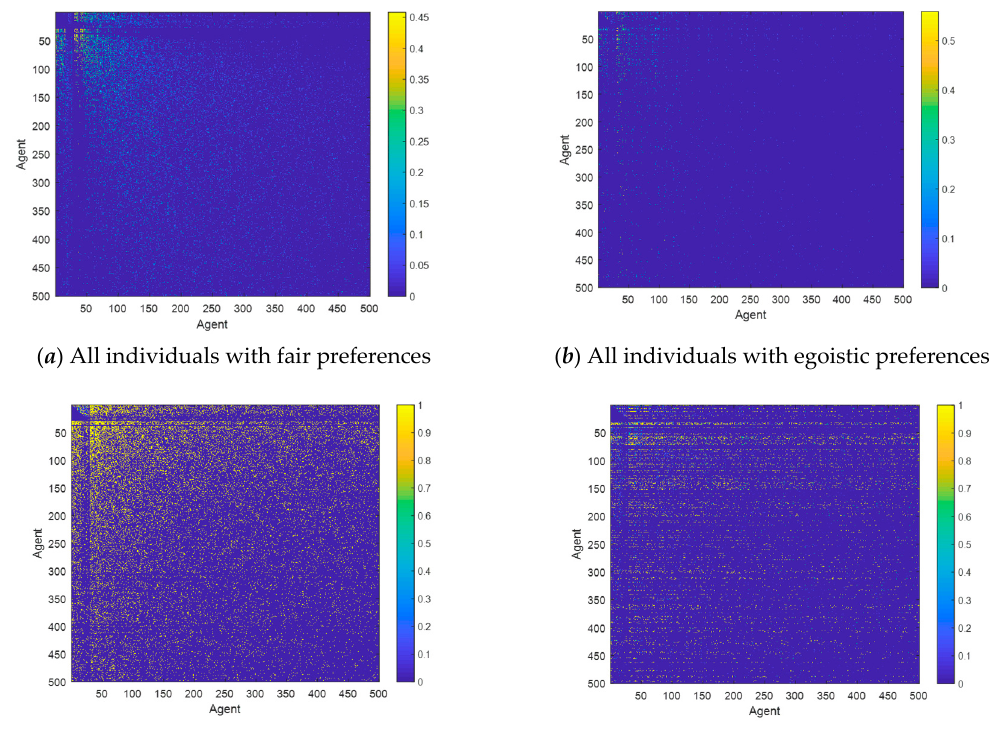
Figure 10. Attitude values of individuals at different times.